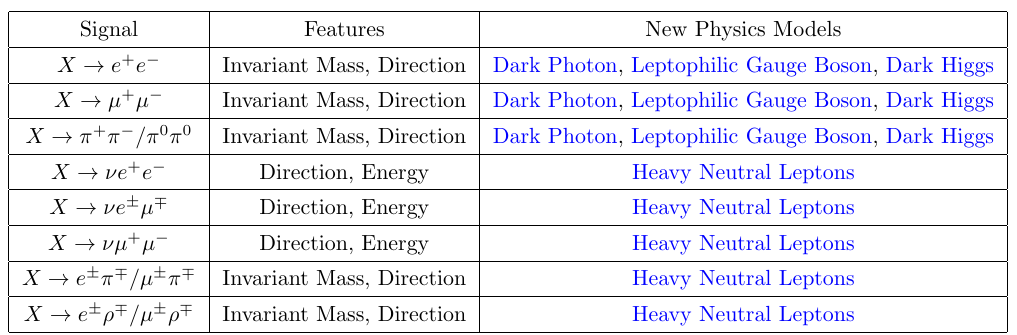
Table 2 . Expected decay signatures of new physics processes. In the left column, X represents the new physics particle